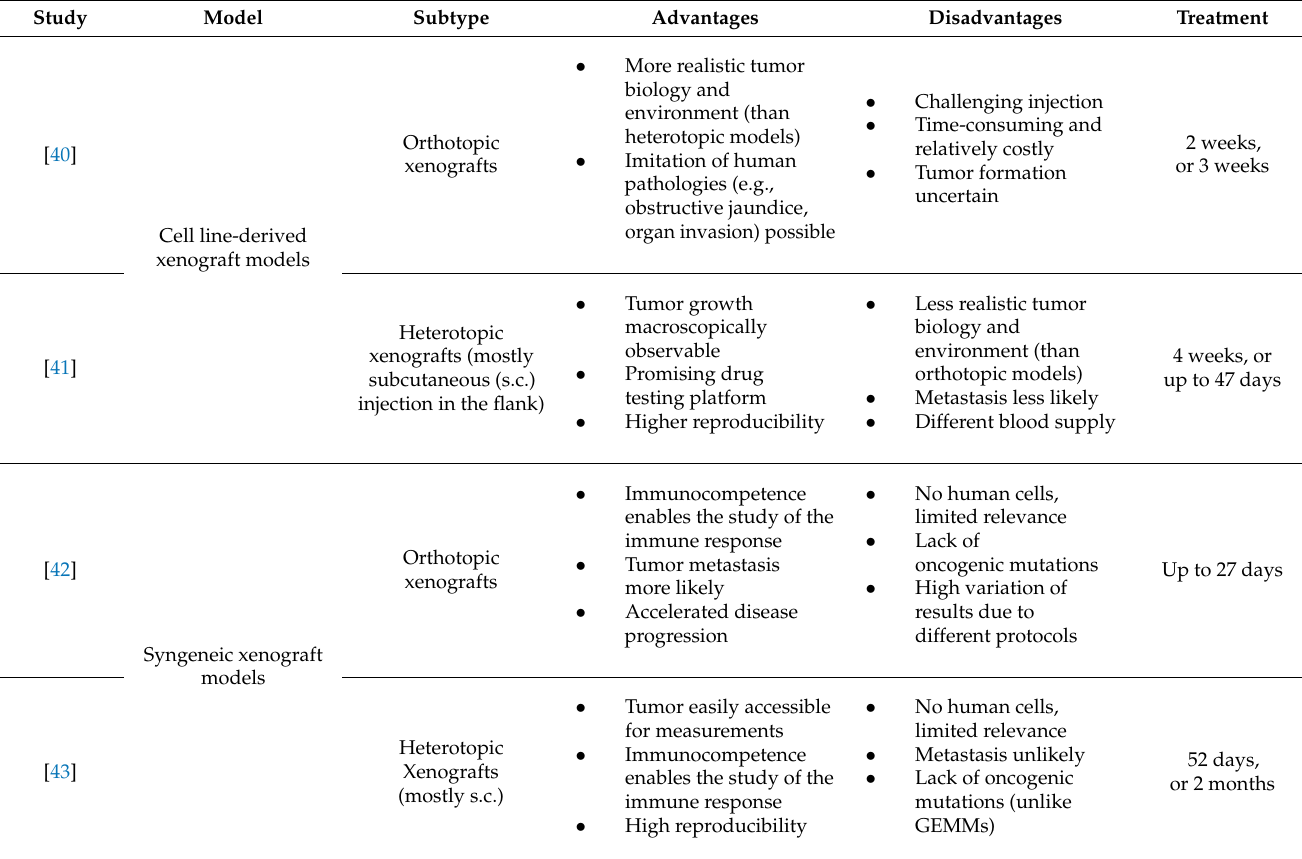
Table 1. Overview of current murine models for the investigation of pancreatic